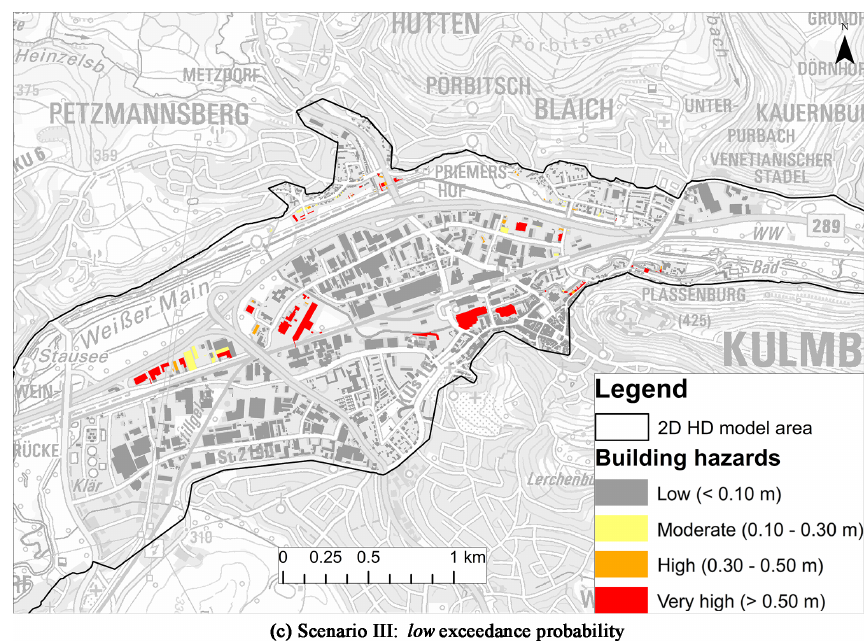
Figure 8. Building hazard maps for the three scenarios; the numbers of affected buildings are 84, 107 and 142 respectively. Hazard classifica- tion is based on Krieger et al. (2017). (Data source: Geobasisdaten © Bayerische Vermessungsverwaltung, http://www.geodaten.bayern.de, last access: 5 March